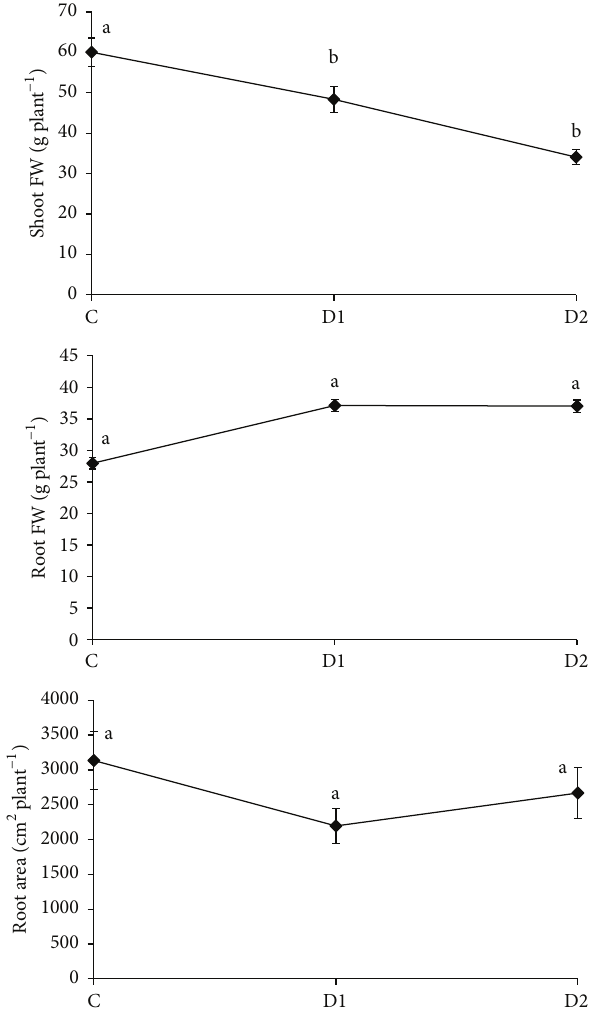
Figure 1: Effects of PEG levels (0, C; 2%, D1; and 4%, D2) on shoot and root fresh weight (FW) and root area of Thymus citriodorus. Values are mean ± SD of nine